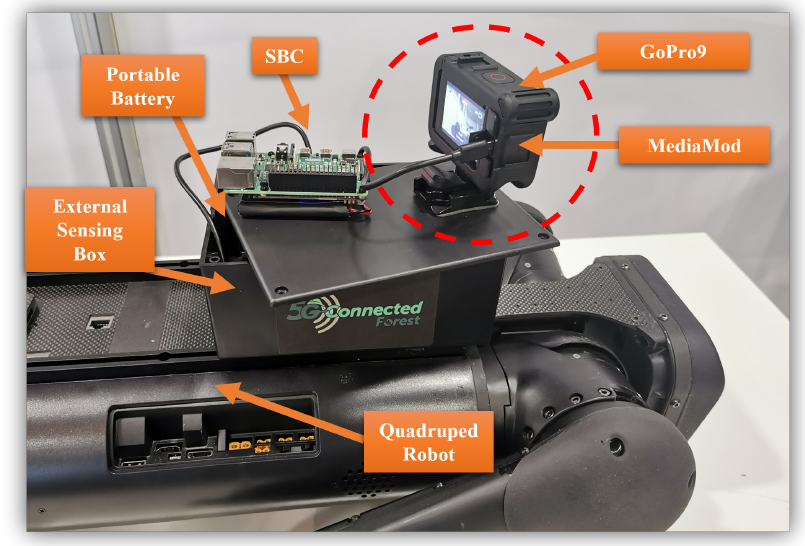
Figure 5. External visionary sensor carried by the Aliengo to monitor the forestry